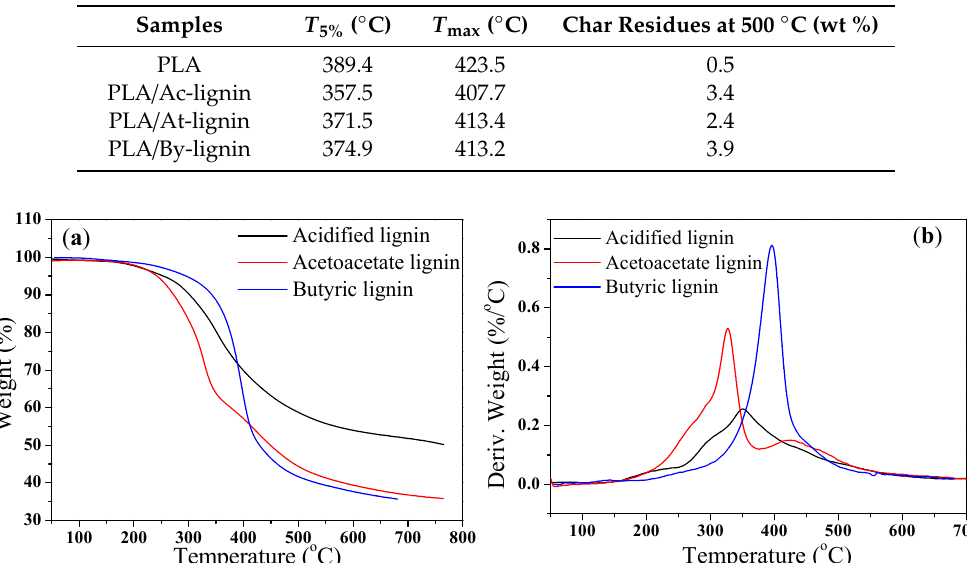
Figure 15. TGA ( a ) and DTG ( b ) curves of acidified, acetoacetate, and butyric lignin. Table 3. Characteristic thermal degradation temperatures ( T max ) and wt % of char residues from TGA curves.